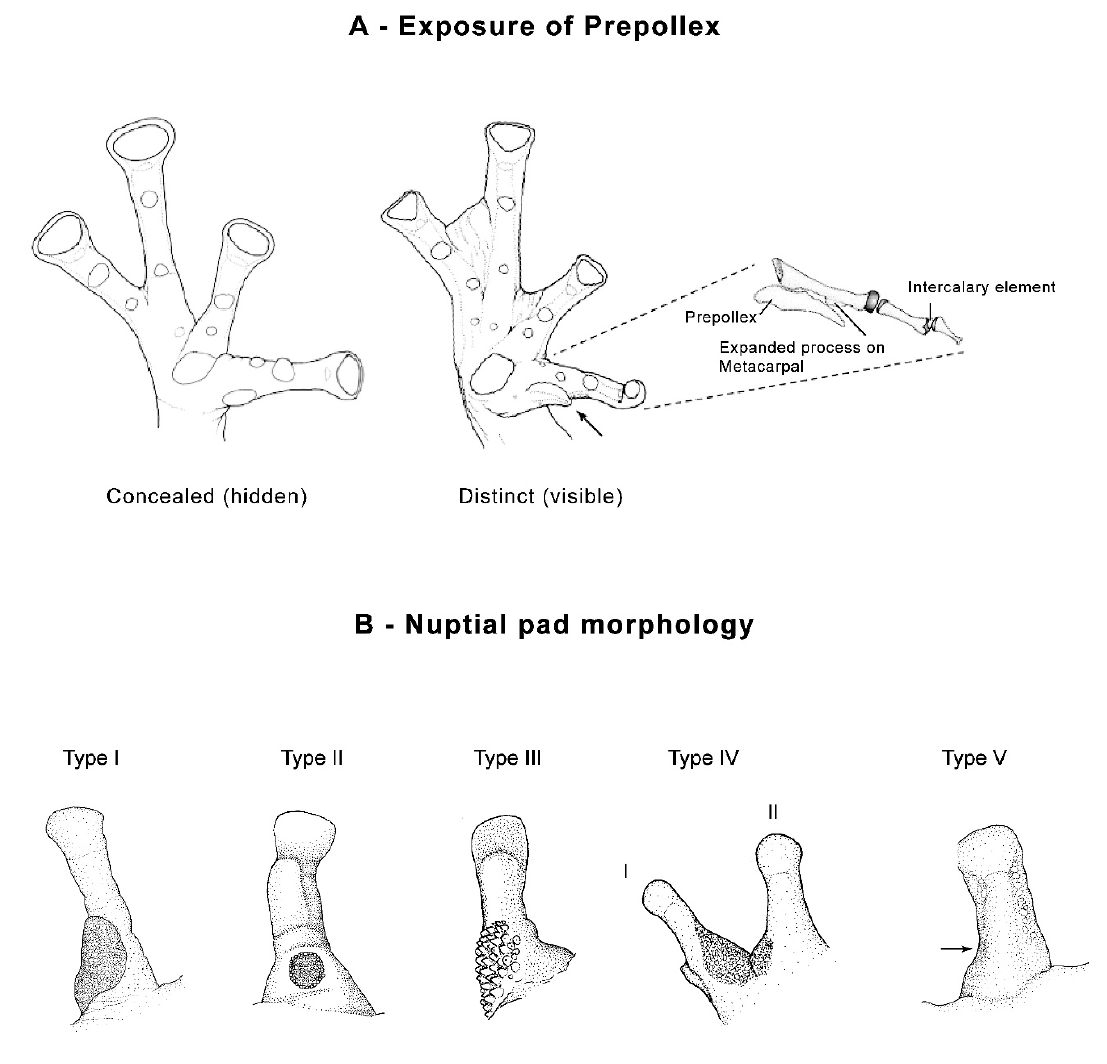
Figure 12. Prepollex and nuptial pad morphology in glassfrogs. ( A ) Condition of the prepollex. Concealed, Nymphargus cochranae , QCAZ 31113. Distinct, Teratohyla spinosa , KU 164668. ( B ) Nuptial pad morphology. Type I: Large to medium-size nuptial excrescence present on the dorsal, lateral, and/or ventral sides of the thumb; Cochranella posadae , QCAZ 26023. Type II: Small circular or squarish nuptial excrescence present on the dorsal or dorsolateral face of the thumb; Centrolene lynchi , MCZ 97846 (figure modified from Flores 1985). Type III: Medium-size spinous nuptial excrescence extending from the lateral side of the thumb to its dorsomedial surface; Nymphargus armatus , UVC 9400 (modified from Lynch and Ruiz-Carranza 1996). Type IV: Large nuptial excrescence formed by a granular pad that extends from the side of the thumb to its dorsomedial surface, and on the proximal dorsolateral surface of finger II; Cochranella litoralis , ICN 13821. Type V: Medium-size diffuse nuptial excrescence formed by glandular clusters and individual glands; a pad as such is absent; Hyalinobatrachium aureoguttatum , QCAZ 27429. Type VI (not illustrated): Nuptial excrescences formed by a combination of clustered and individual glands that sparse along the flanks of the body (see text).